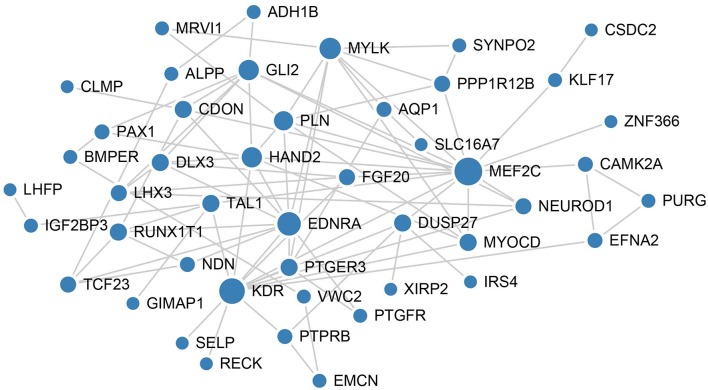
PPI network analysis of mRNAs involved in the ceRNA network of these four lncRNAs. The size of each node represents the degree of this gene.